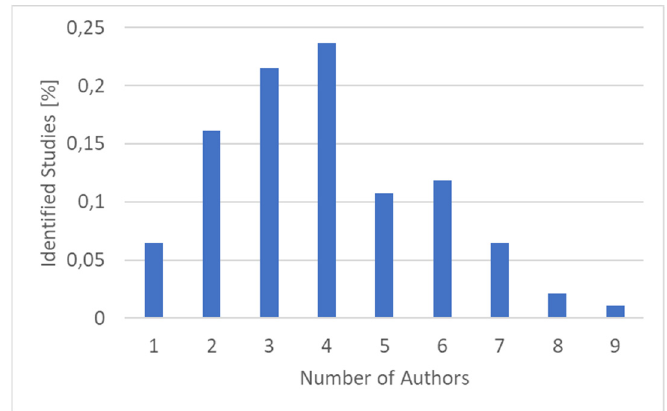
Figure 3. Research collaborations.